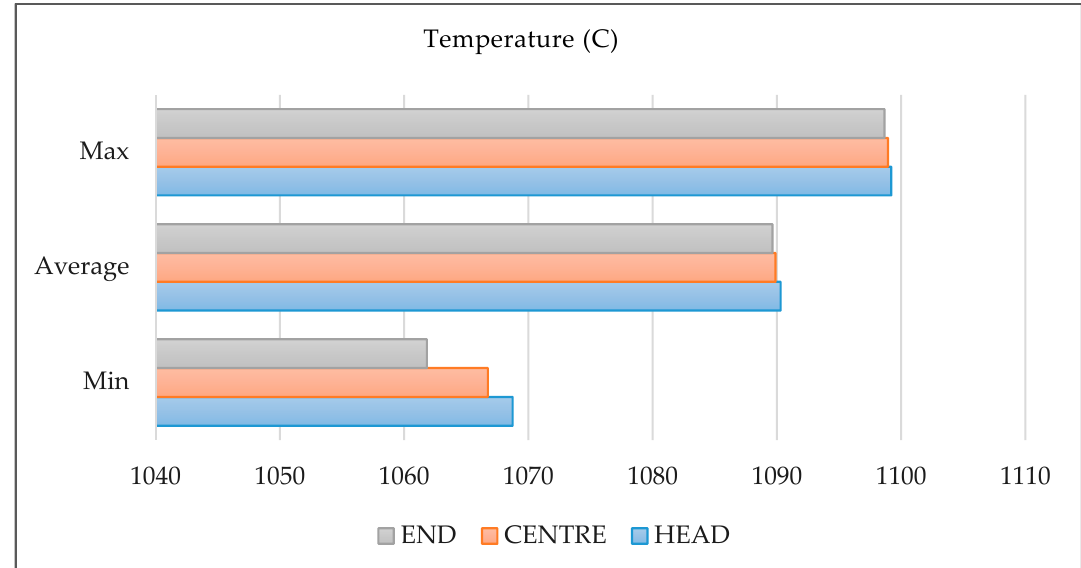
Figure 13. Temperature filed comparisons at the end of the reversing rolling simulation. Different initial slice positions are chosen and compared.